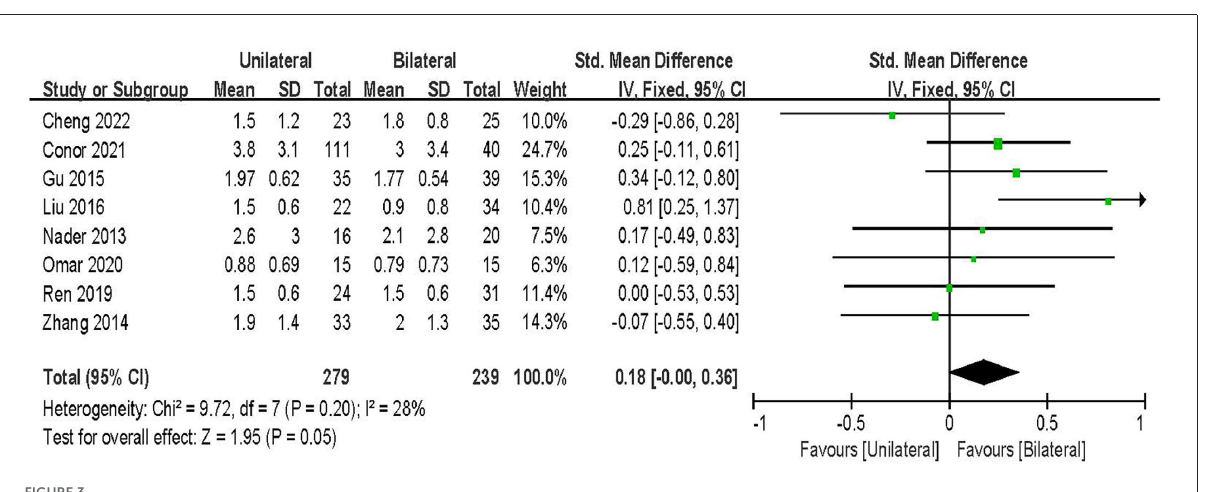
FIGURE3 Forest plot of VAS-Leg pain at final follow-up.